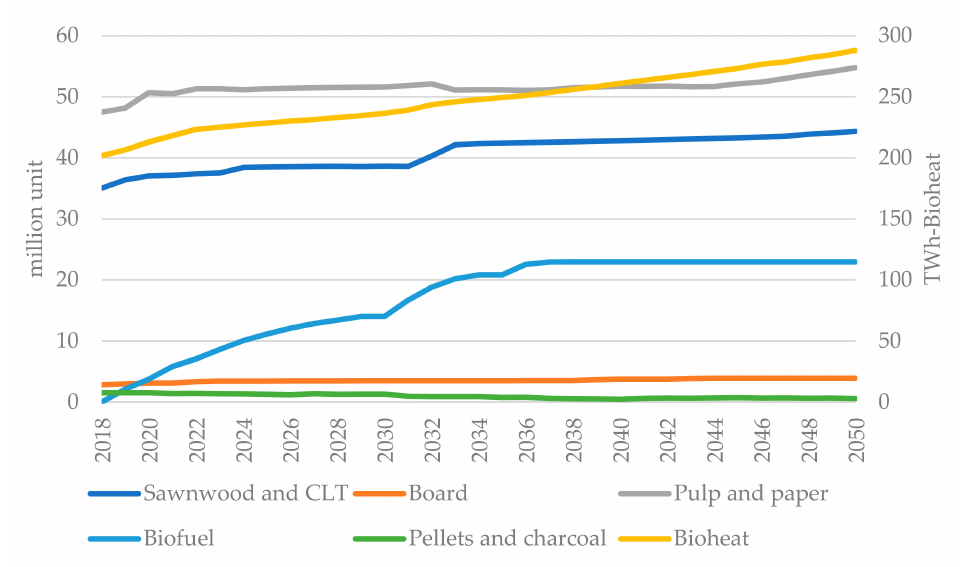
Figure 8. Modelled Nordic production of the main categories. Bioheat includes district heat, local heat and industrial heat. Biofuel in million L on the left axis and bioheat in TWh on the right